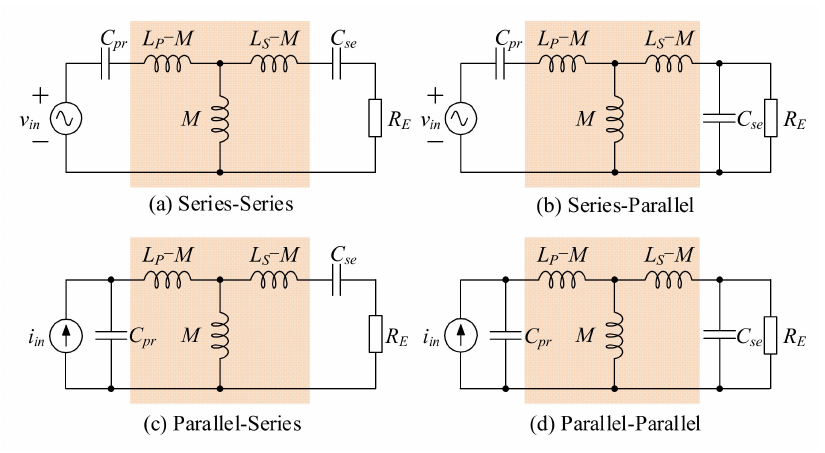
Figure 3. Four basic inductive power transfer (IPT) circuits.